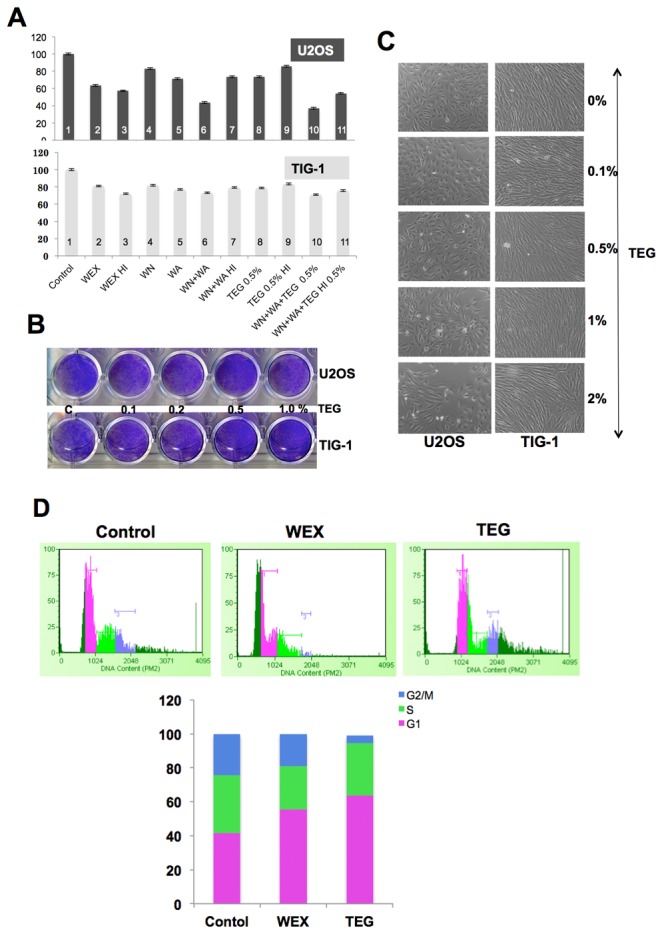
Cancer cell toxicity analysis of TEG.(A) Heat inactivated WEX (ASH-WEX), TEG, WA (withaferin A) and WN (withanone) were tested for cancer cell cytotoxicity. WEX and TEG retained their cancer cell toxicity even when inactivated by heat (compare: bars 2 and 3, bars 8 and 9). Statistical significance of the data as calculated by One-way ANOVA test is indicated by * (P<0.01) for control and treated cells, and # (P<0.001) for control and heat inactivated samples. (B and C) Cancer cells treated with serial doses of TEG for 48-72 h showed decrease in cell number whereas the normal cells showed minor increase. (D) Cell cycle analysis of WEX and TEG treated cancer cells revealed increase in number of cells arrested at G1 phase.